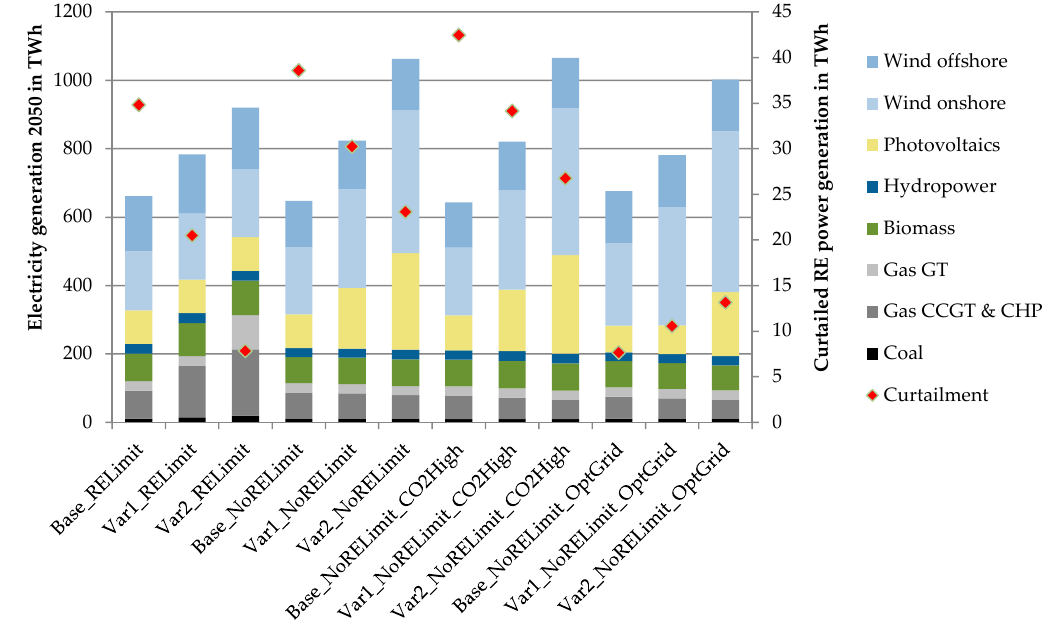
Figure 2. Electricity generation mix and calculated curtailment of RE power generation in 2050 for all scenario variants and cases. (GT: gas turbines. CCGT: combined cycle gas turbines. CHP: combined heat and power plants).